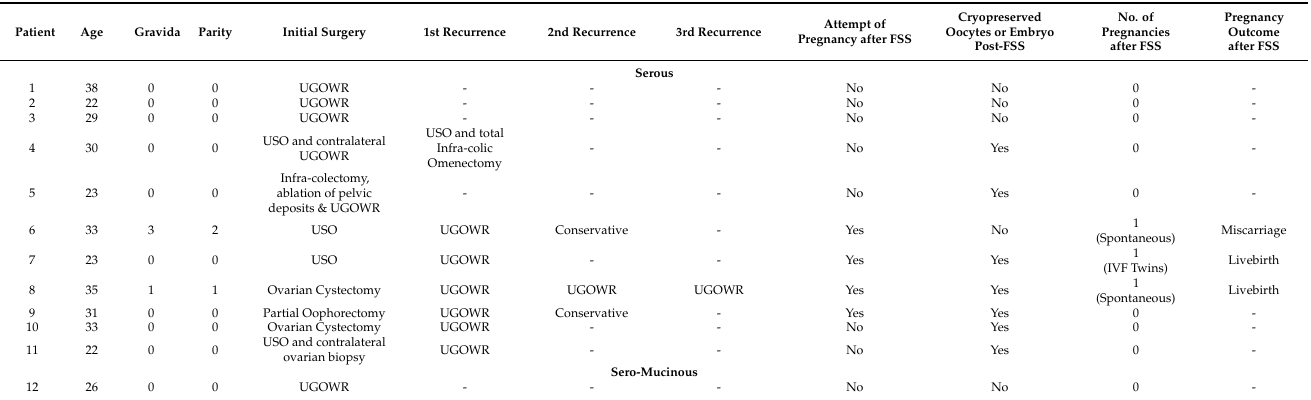
Table 8 summarises the surgical and reproductive outcomes from women who under- went UGOWR. Table 8. Surgical and reproductive outcomes following laparoscopic ultrasound-guided ovarian wedge